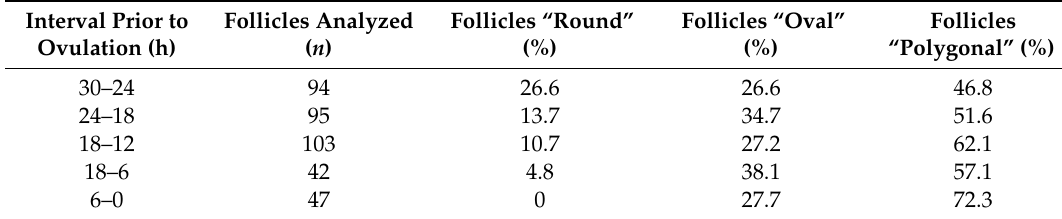
Figure 6. Transabdominal ultrasonographic images of ovaries in sows in estrus with round-oval ( A ) and polygonal pre-ovulatory follicles ( B ). ( A , B ) Squares mark the transversal and longitudinal dimension of the ovaries. Example cross-sections of the uterine horns (white, dotted arrows) and blood vessels (red arrows) are identified. Scale bars on right margins in 0.5 cm steps. Table 1. Breakdown of follicle shape in relation to time prior to ovulation in multiparous sows (n = 10) imaged transabdominally at 6 h intervals [modified according to